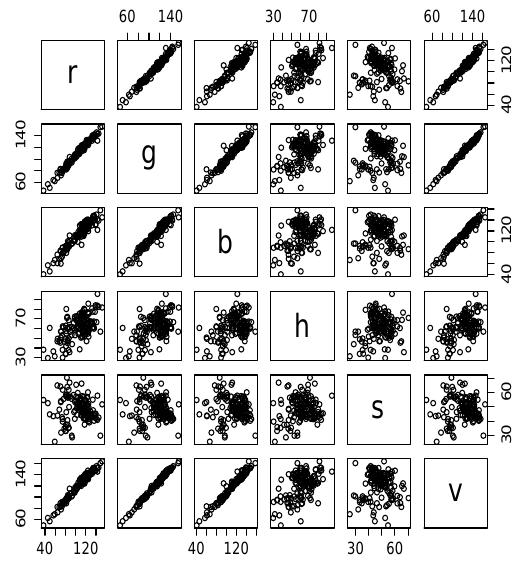
Figure 1: RGB and HSV Histogram Matrix. Each dot represents a image tile in the full product.